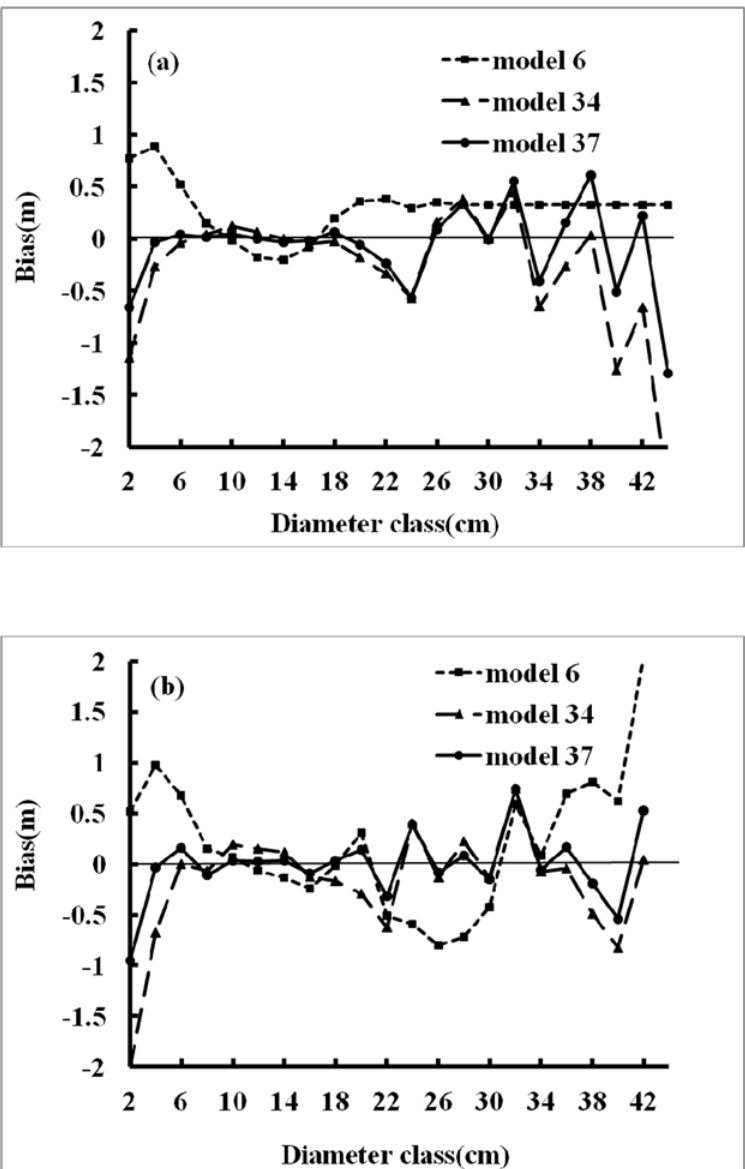
Fig 7. Values of average bias in relation to dbh in the calibration and validation datasets for the two best models (a: calibration data; b: validation data).